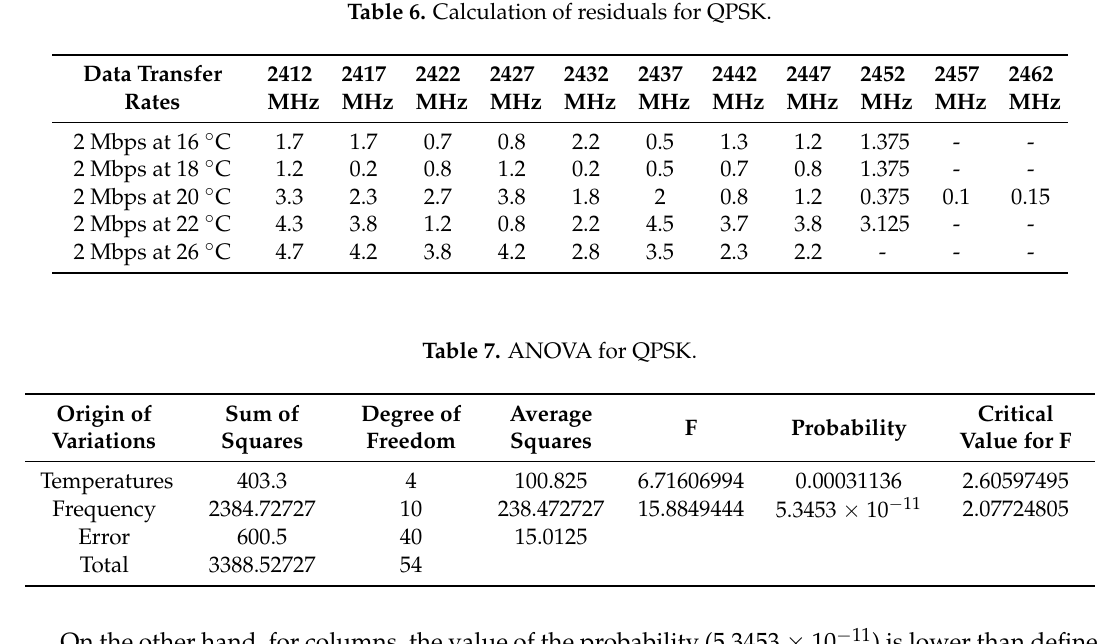
Table 6. Calculation of residuals for QPSK.